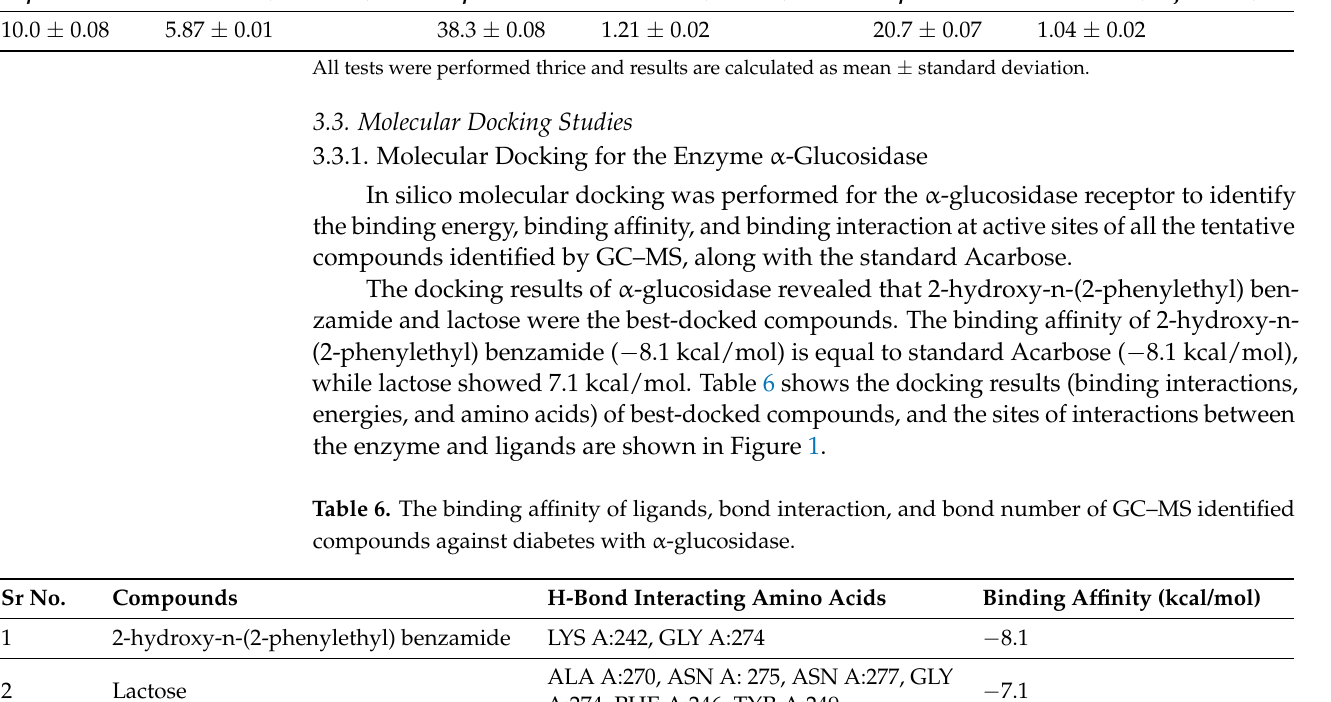
Table 5. IC 50 values of enzyme inhibition of ethanolic extract of Z. pentandra ( µ g/mL). α -Glucosidase Inhibition